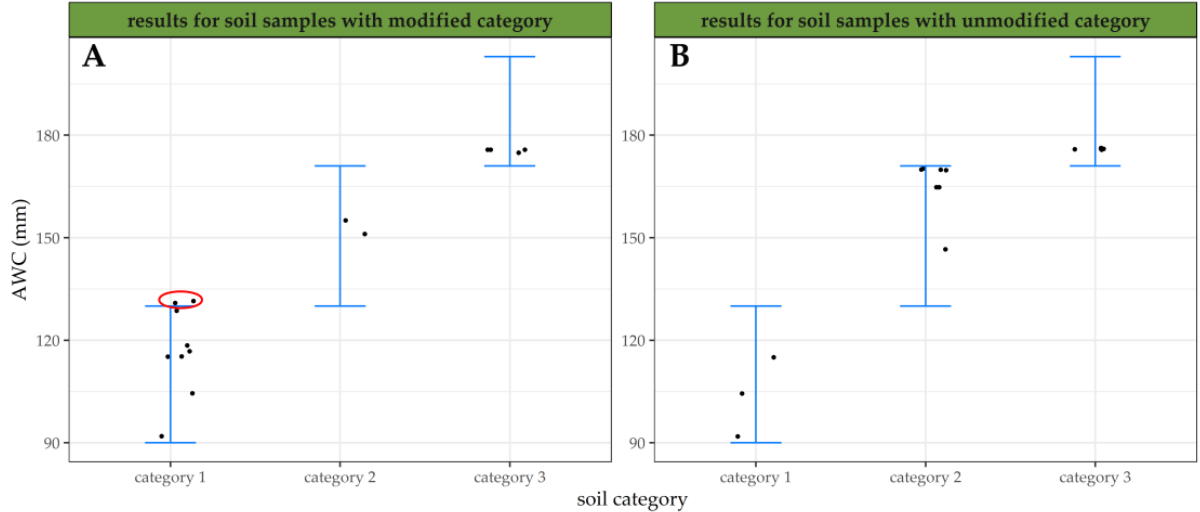
Figure 6. Validation results of 30 soil samples with: modified category ( A ) and unmodified category ( B ).